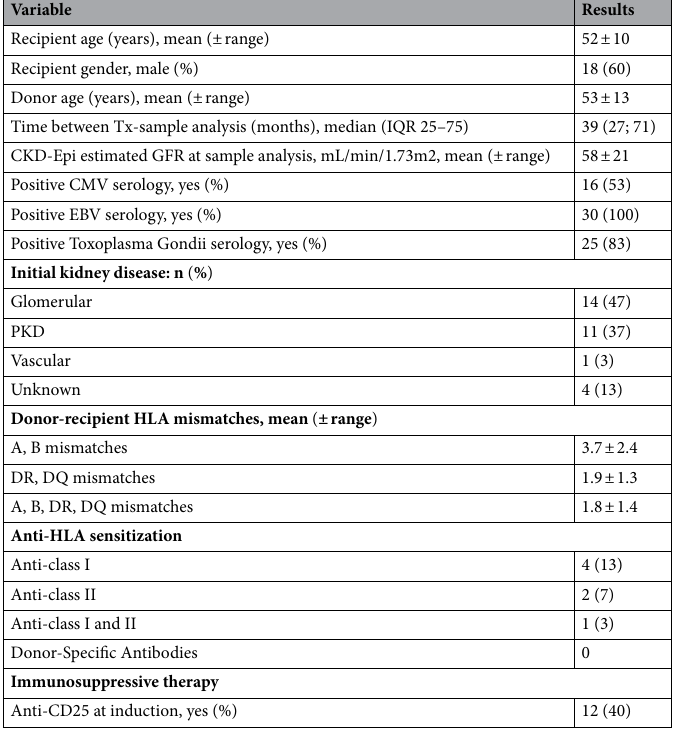
Table 1. Main characteristics of the 30 living-donor kidney transplant recipients included in the inhibitory receptors expression changes after transplantation. Tx Transplantation, GFR Glomerular Filtration